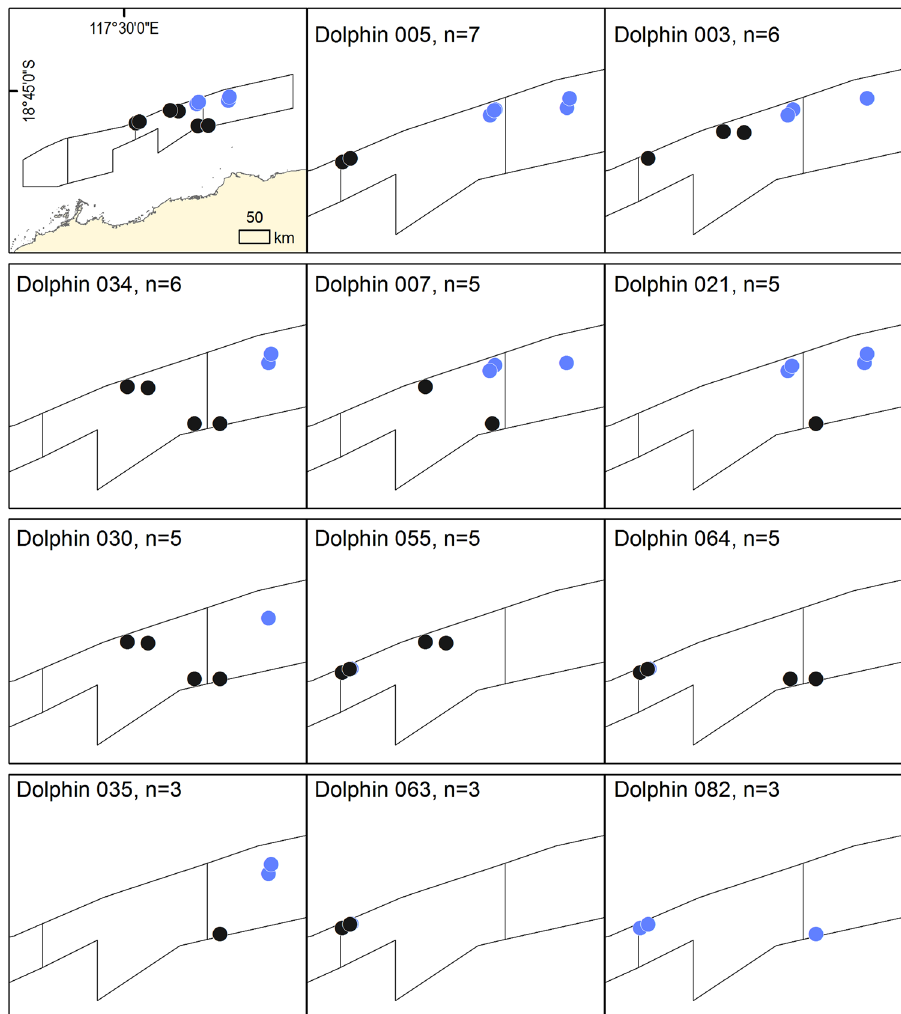
Figure 2. The location of the 12 dedicated photo-identification surveys conducted from one trawler in April 2011 (top left frame) and the photographic captures/recaptures of the eight bottlenose dolphin ( Tursiops truncatus ) individuals sighted five to seven times ( = trip 1; ● = trip 2); Also shown in the bottom panels are the locations of the three individuals (dolphin identification numbers 035, 063, and 082) sighted three times in April 2011 that were matched with opportunistically collected images taken in October and November 2008 (initial locations not shown). This figure was generated in ArcGIS v10.1.